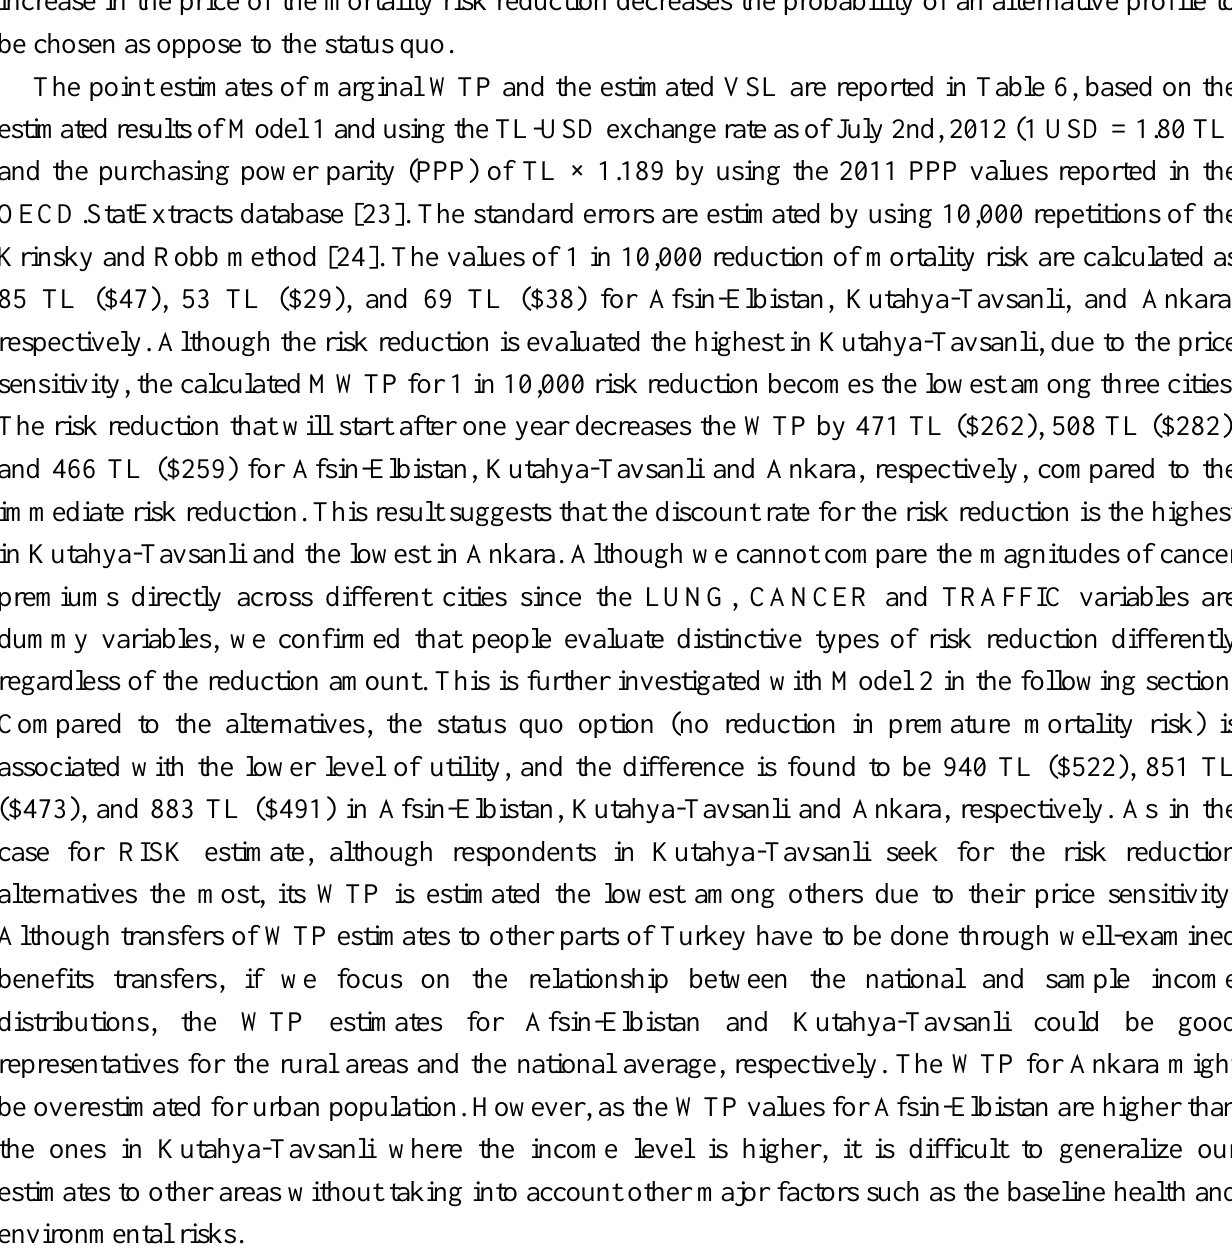
Table 6. Point Estimates for Marginal WTP and Estimated VSL based on Model 1 (TL).